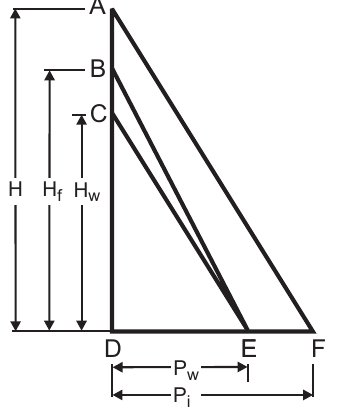
Figure 3. Geometric force balance according to Hughes (2008). H represents ice thickness, H f the flotation height or height of the ice column supported by basal water pressure, and H w the piezometric height; P w and P i represent the basal water pressure and weight of the ice column, respectively. Ice flow is from right to left.